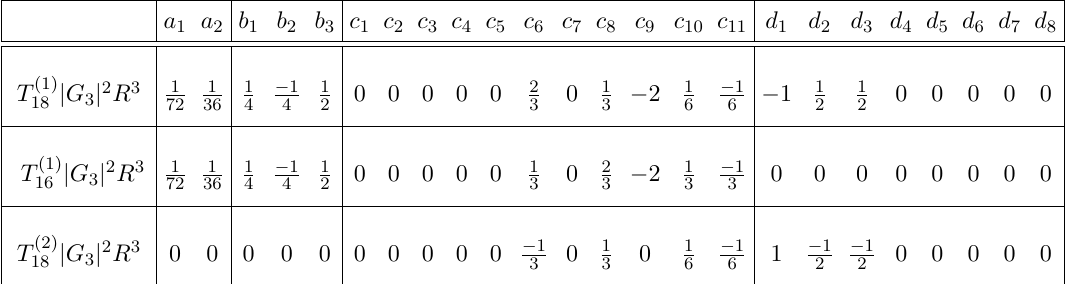
Table 2: Decomposition of leading order flux terms obtained from t 24 R 4 in the 24 component basis for R 3 defined in appendix